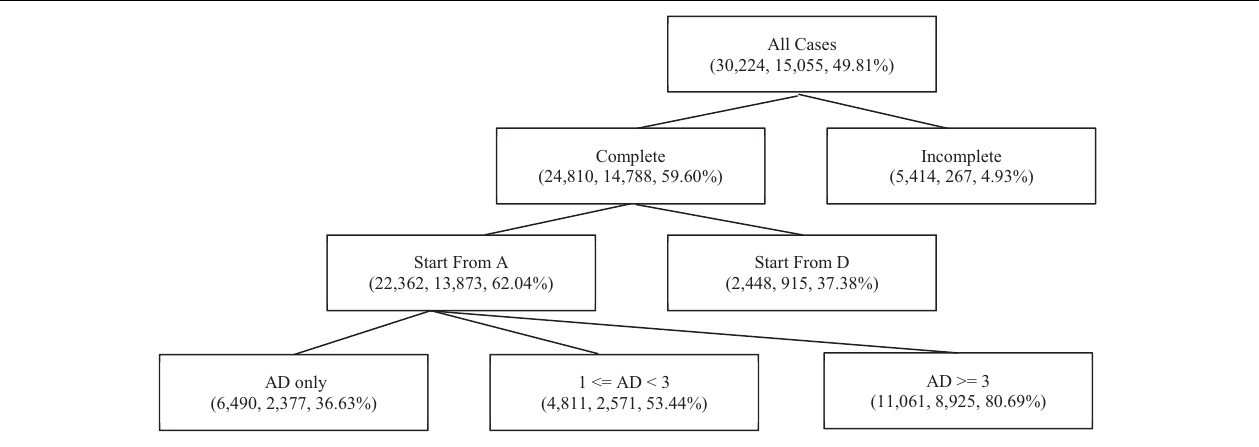
FIGURE 2 | A tree-based diagram for contracted levels of the AD sequence. Indices in parentheses are sample size, number of correct responses, and conditional probability of correctness, respectively, for each class or contracted class of the “AD sequence” variable.